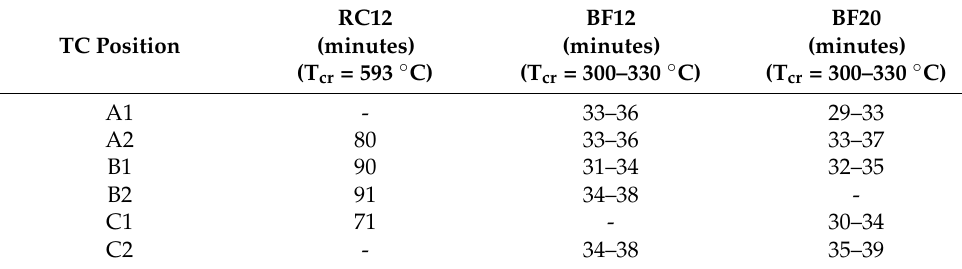
Figure 10. Comparisons in the temperature: ( a ) RC12 and BF12; ( b ) BF12 and BF20. Table 4. Critical temperature of reinforcing steel and GFRP rods of sample